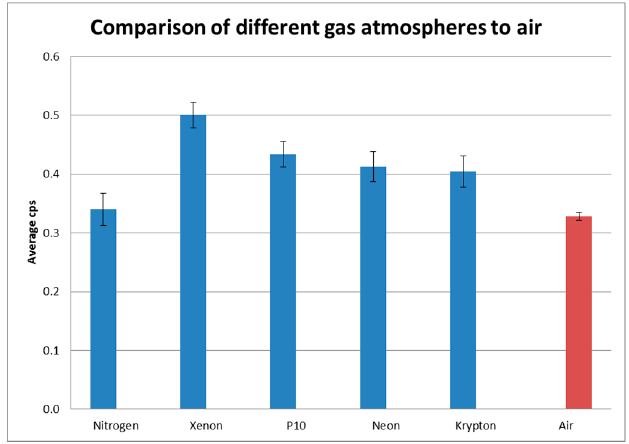
Figure 6. Comparison of average cps in different gas atmospheres. Table 2. Variation in average counts per second (cps) by gas in comparison to air.